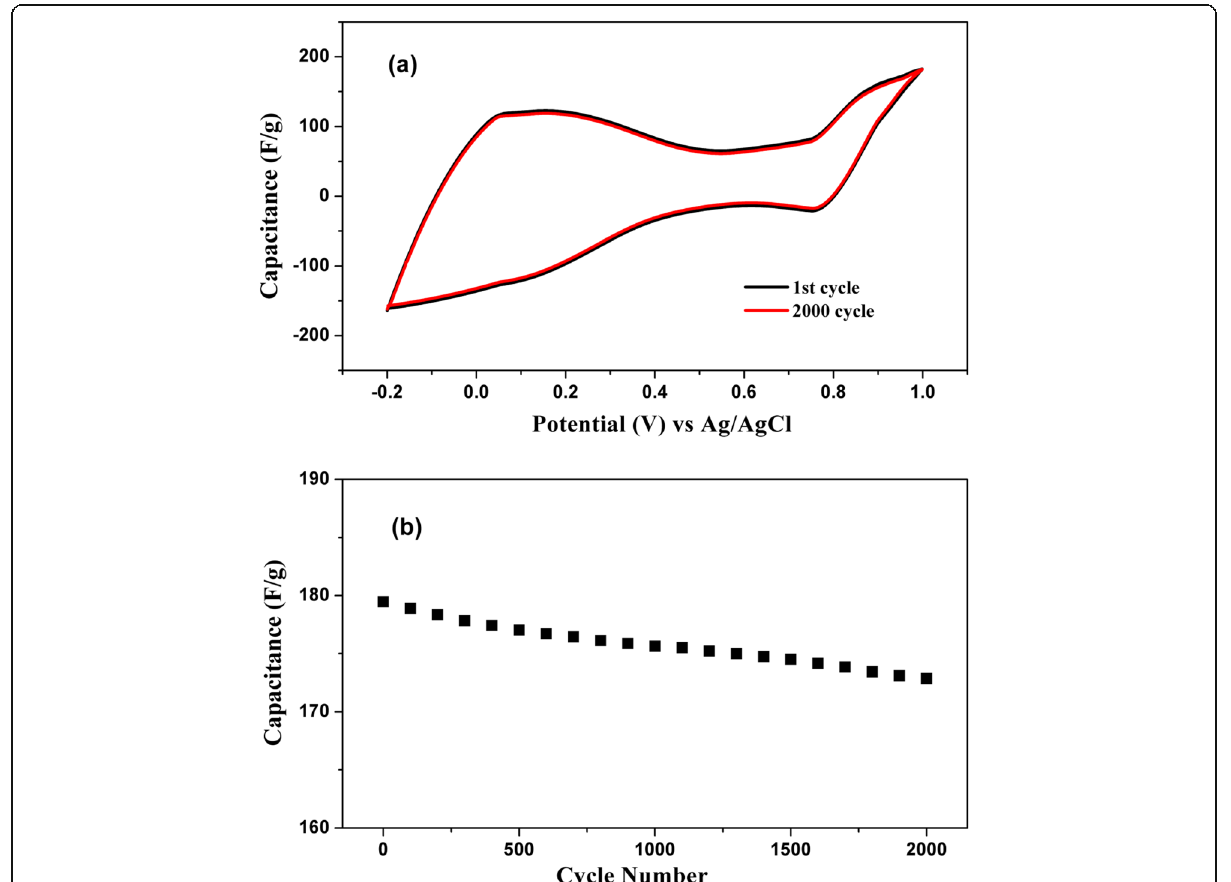
Fig. 7 Capacitance against a potential and b number of cycle using 9-CNT/mwGO/RVC electrode measured at a scan rate of 5